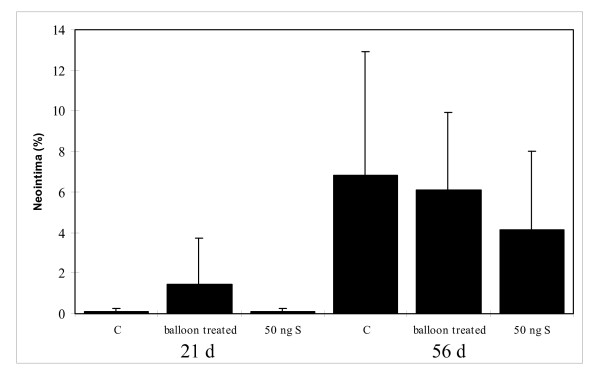
In the ex vivo HOC-model the effect of 21 days incubation with SRL (50 ng/ml) on neointimal hyperplasia was studied 21 days and 56 days after ballooning. SRL inhibited neointimal hyperplasia, statistical significance was not achieved.